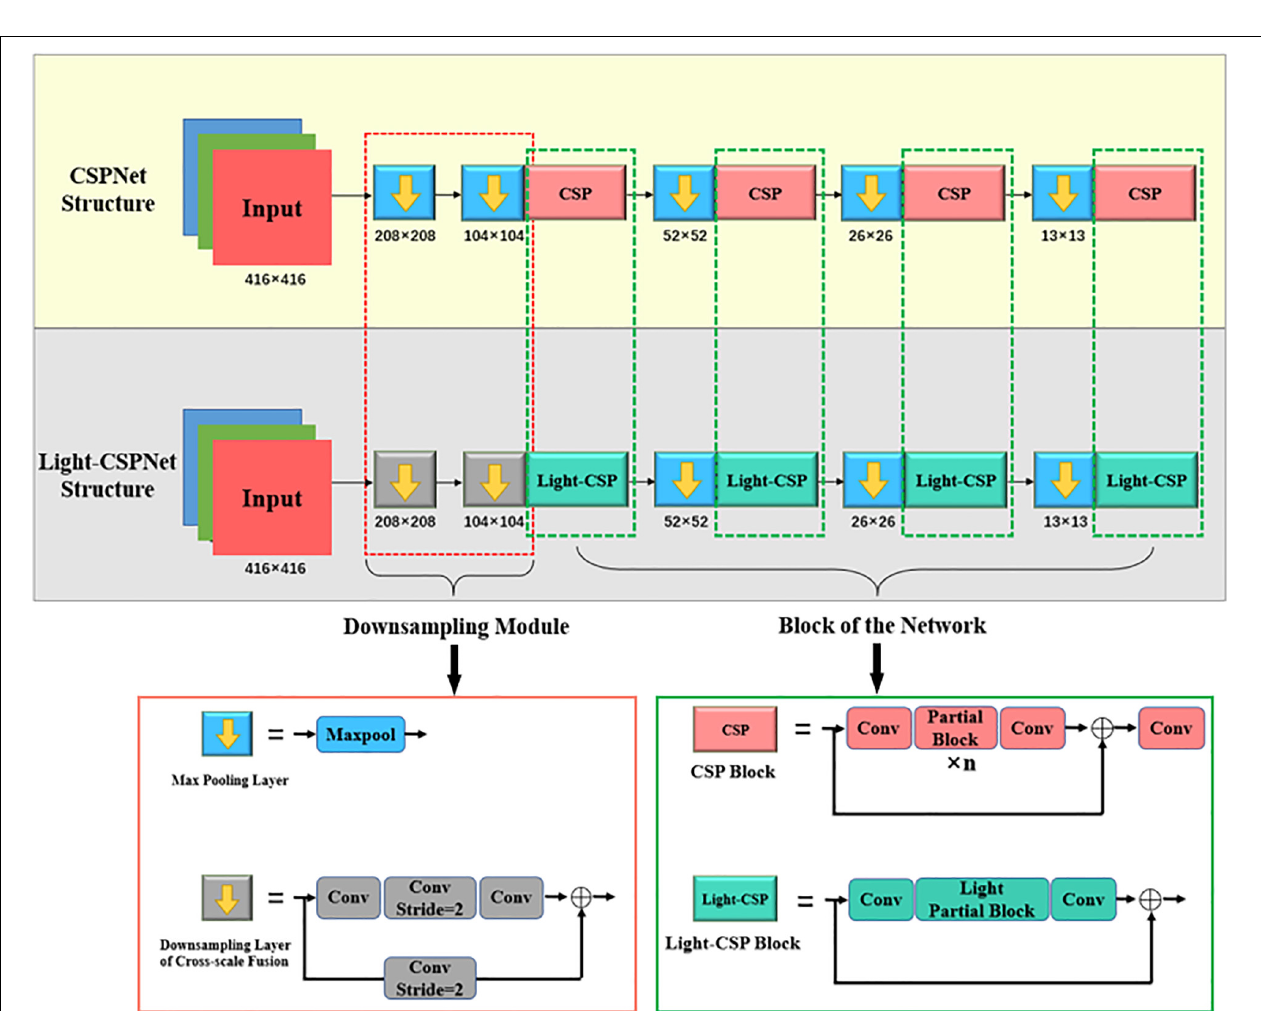
FIGURE 2 | Comparison of CSPNet and Light-CSPNet backbone